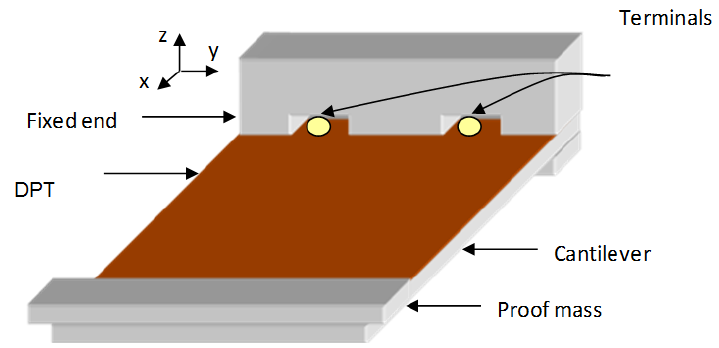
Figure 7. Vibration based energy harvester